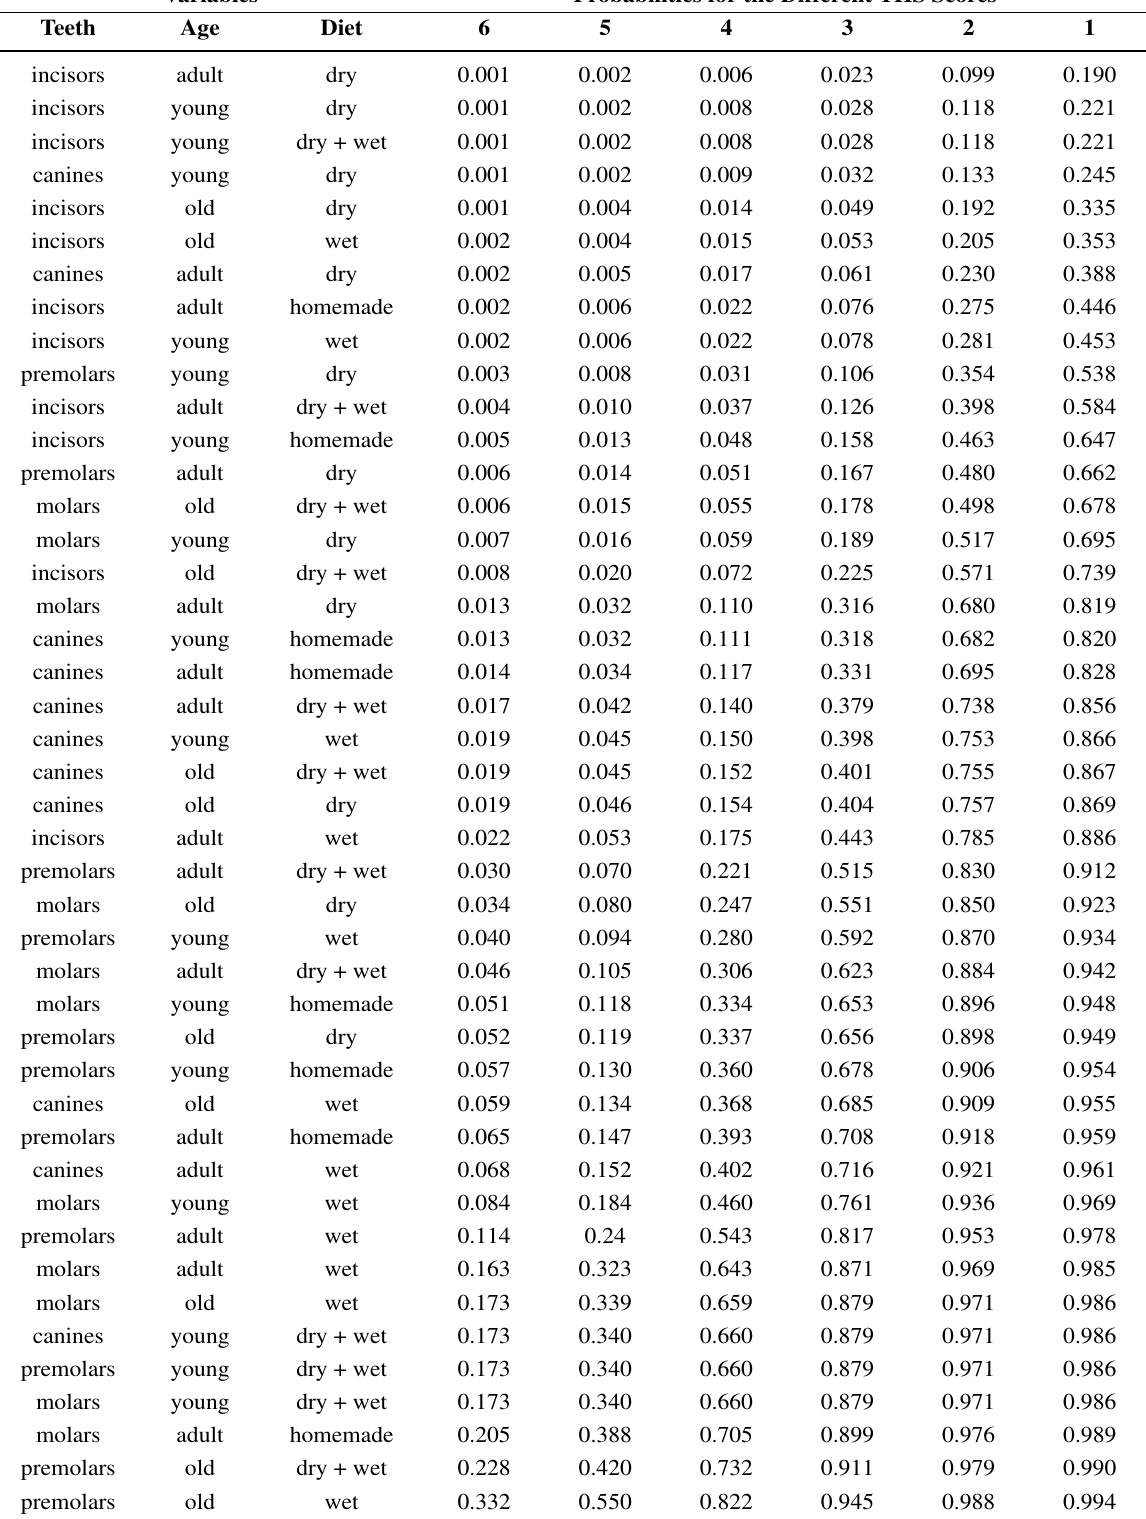
Table 2. Probabilities of THS score in dependency on the different combinations between the levels of the factors analysed (teeth, age, diet). Probabilities are in ascending order to aid